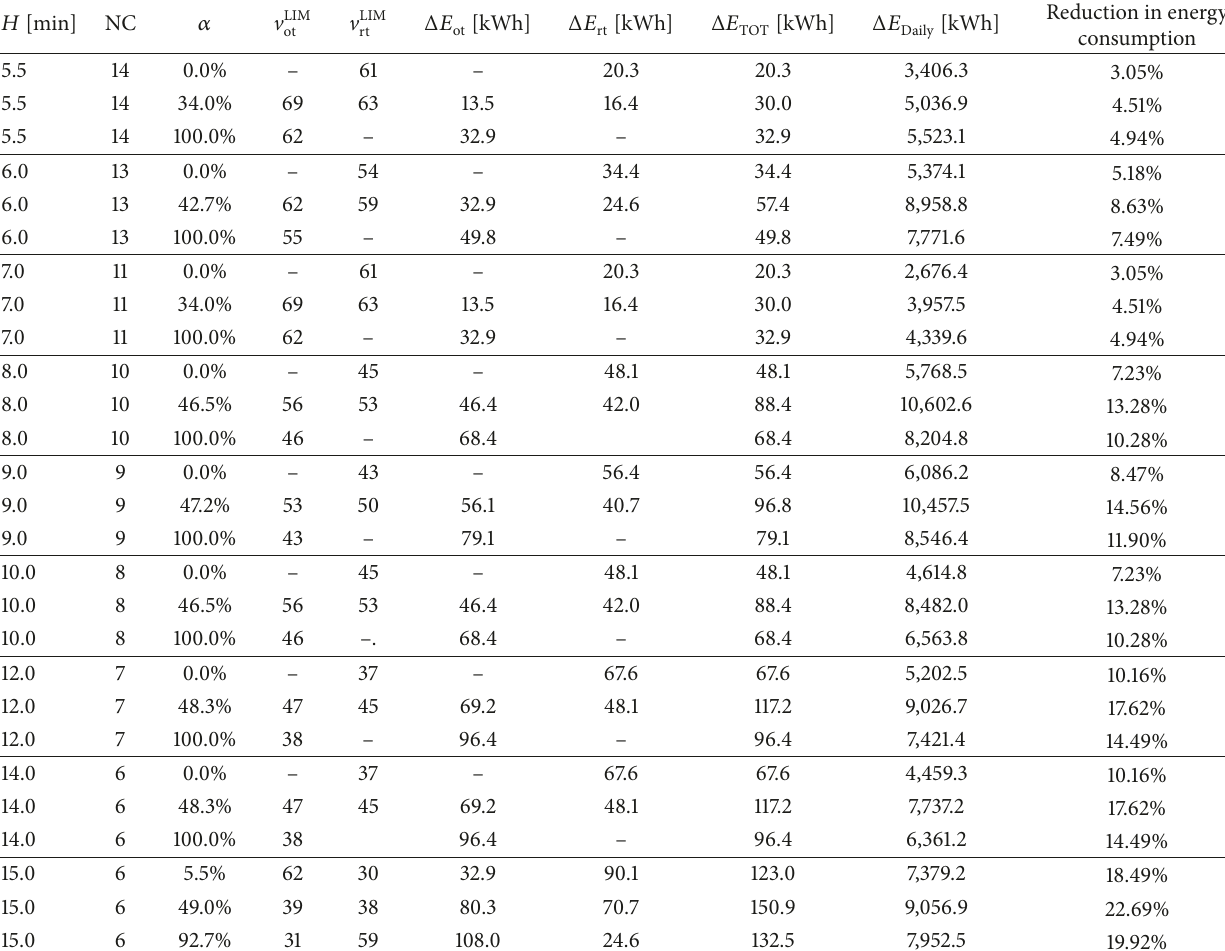
Table 7: Energy variations in the case of the 95th